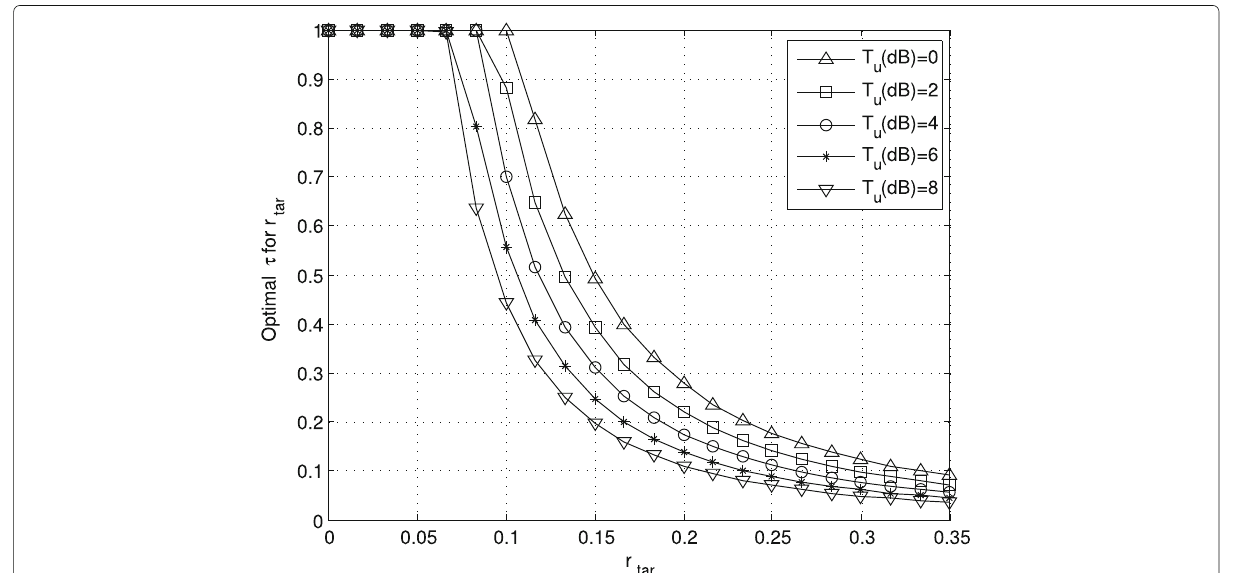
Fig. 4 Optimal TP for varying target distance with different T u when T d (dB)=-10. Since the influence of the interference is small in short target distance, the optimal TP is shown to be higher in shorter target